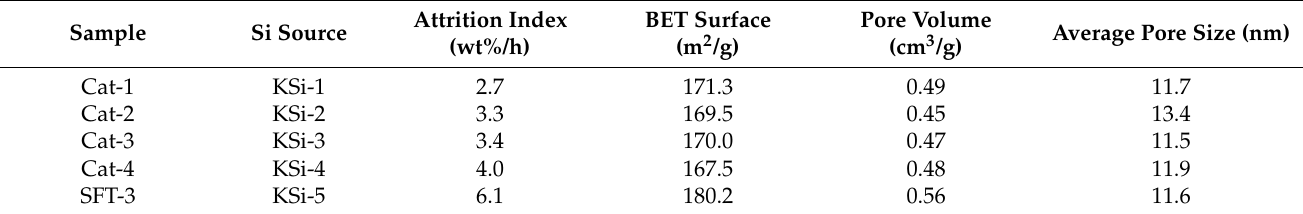
Table 6. Attrition index and physical properties of catalysts prepared with different silica sources.